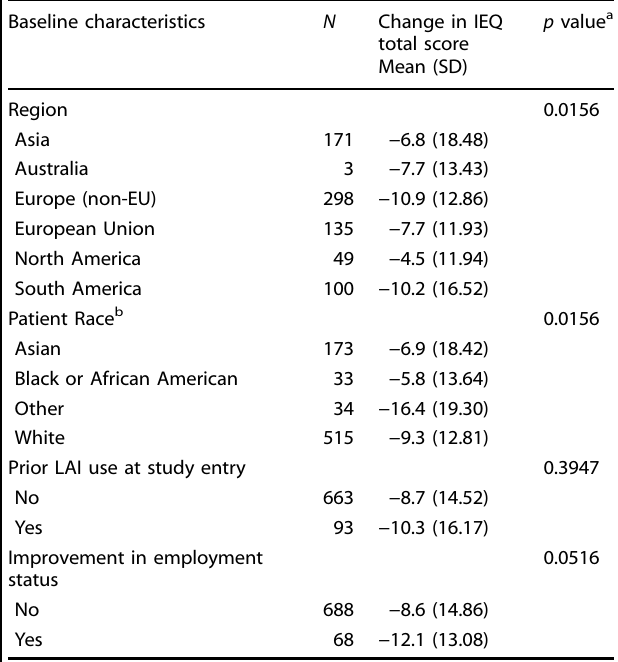
( p = 0.0516) (Table 3). Improvement in caregiver burden was signi fi cantly greater in patients without relapse ( p < 0.001) vs. patients with relapse. Mean (SD) change in the IEQ total score from OL baseline to DB endpoint in caregivers whose relative did not relapse was − 9.8